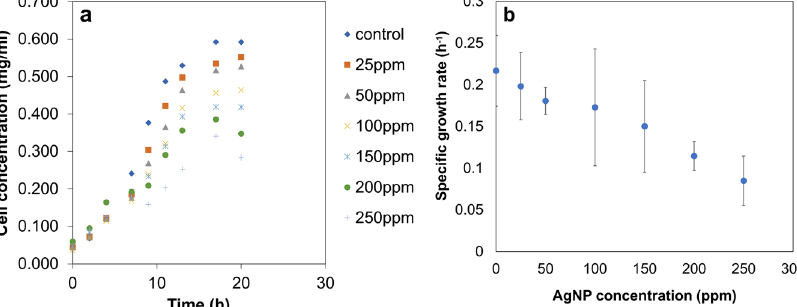
Fig. 2 Variation of E. durans growth with different concentrations of AgNPs. Exposure of bacterial cultures to higher concentrations of the nanoparticles results in a ) excessive cell death and b ) reduced speci fi c growth rates ( p -value = 0.0201). Values are expressed as mean ± SD, n =